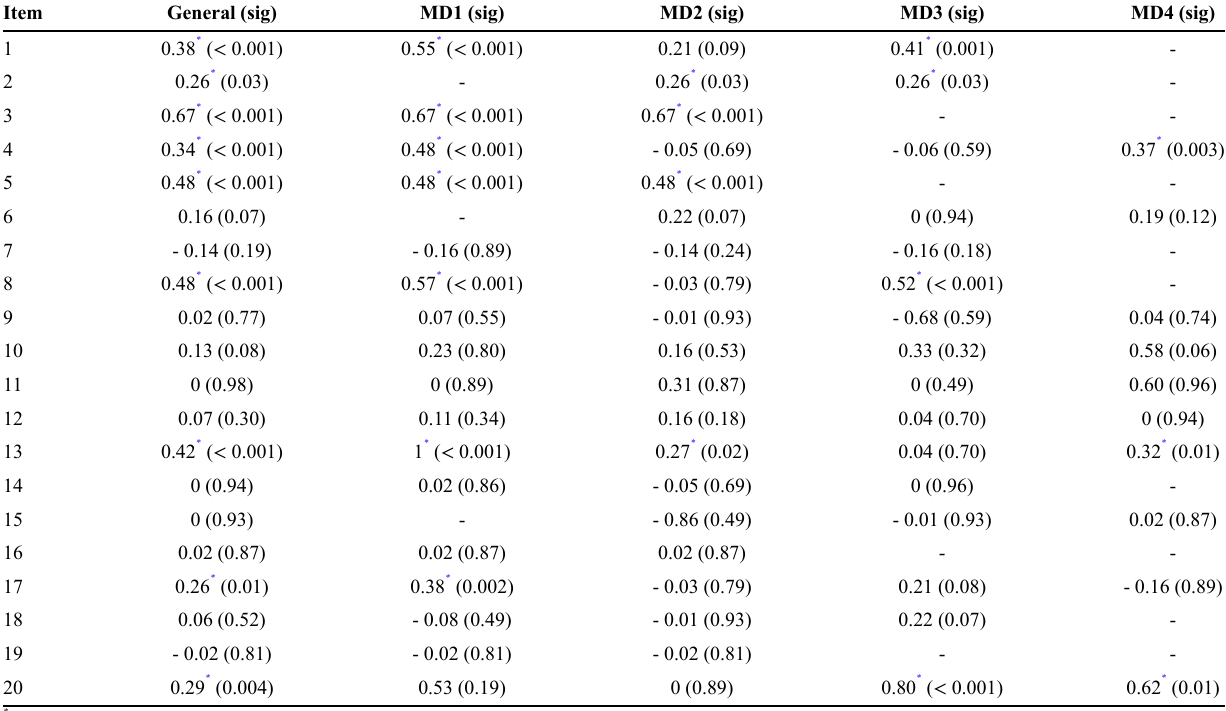
Table 2 - Inter-rater reliability from the initial 20-items checklist and its movement descriptors (MD) of the high upper limb in front crawl proposed in the first step.